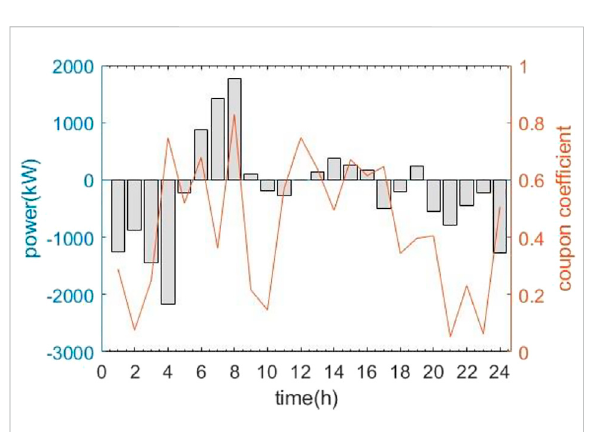
FIGURE 7 Optimal coupon coef fi cient and customer load adjustment.